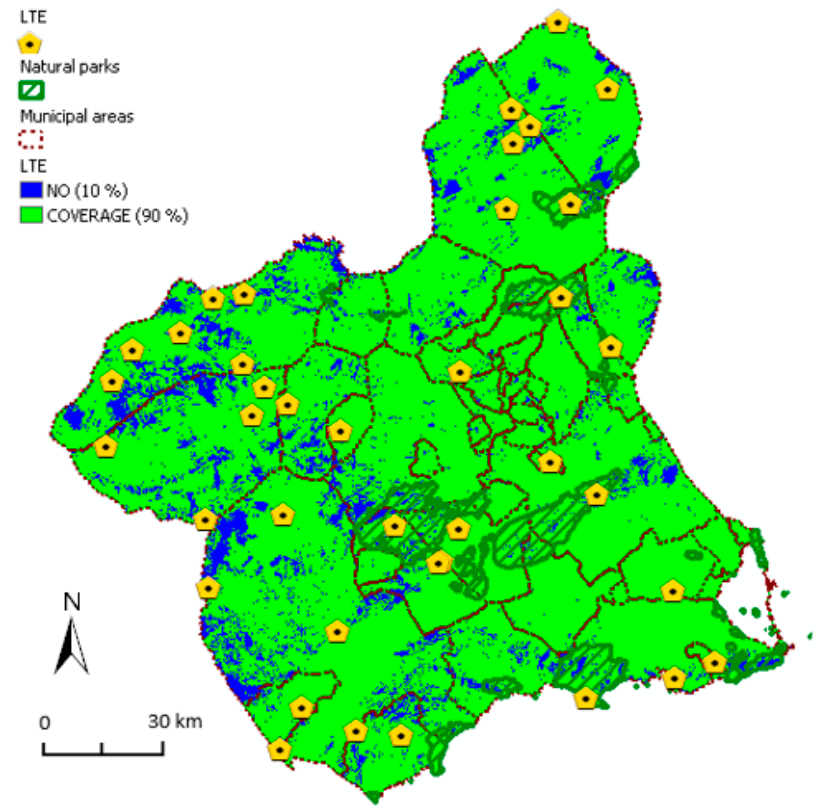
Figure 7. LTE optimized radioelectric coverage (39 sites).